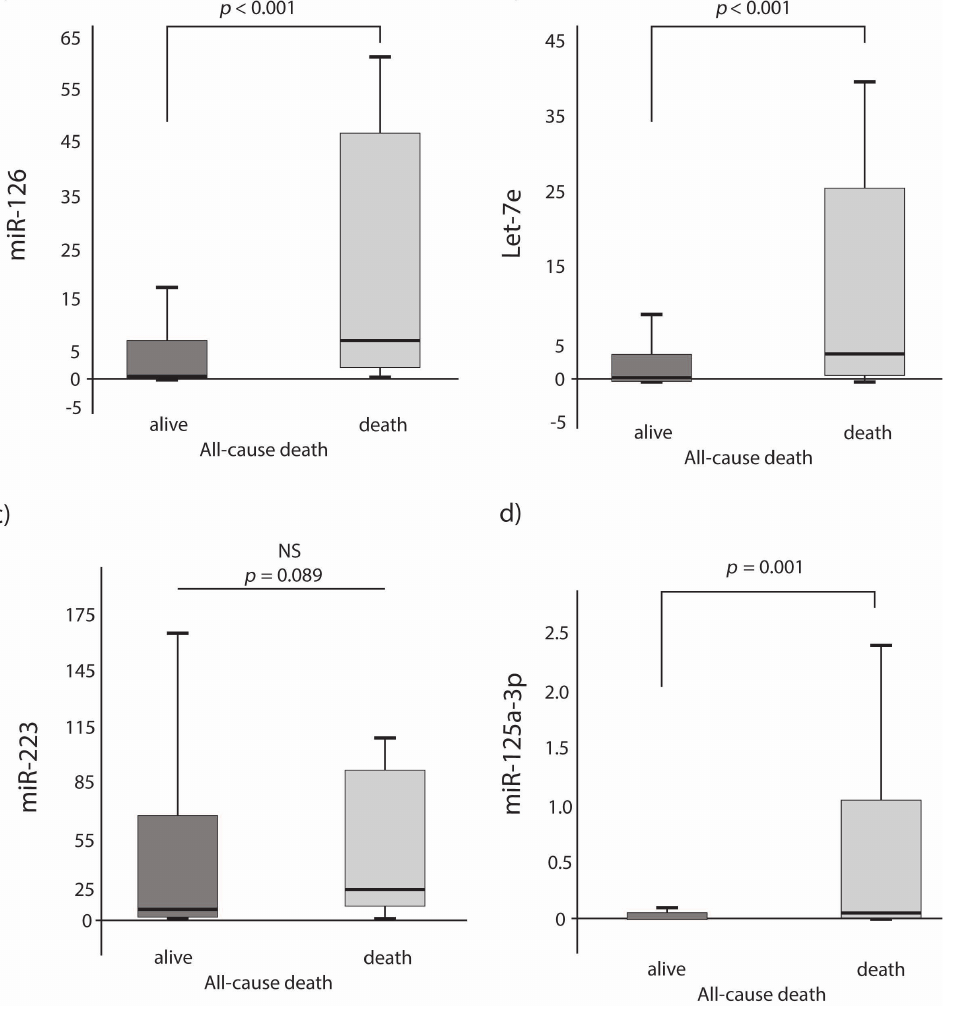
Figure 1. miRNAs expression levels according to survival during the long-term follow-up ( a ) miR-126; ( b ) Let-7e; ( c ) miR-223; ( d )